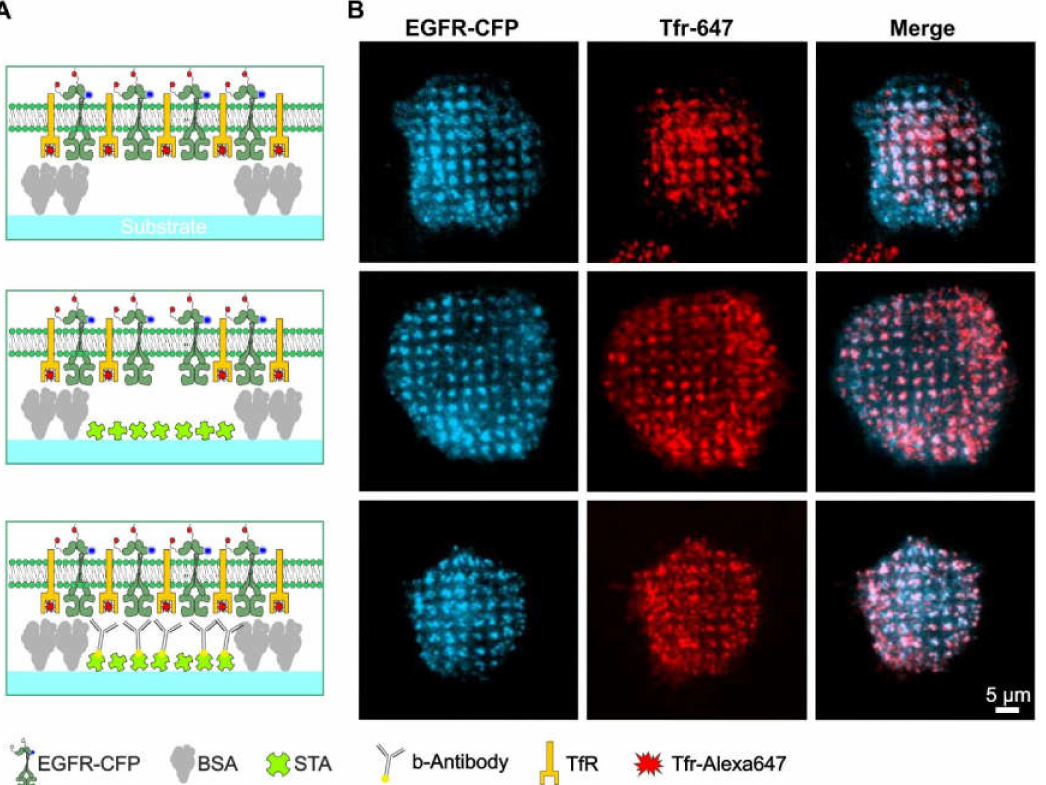
Figure 4. Bait molecules are rearranged irrespective of the presence of specific anti-bait molecules. ( A ) Schematic drawings of the di ff erent degrees of substrate functionalization are presented to the cells. ( B ) TIRF microscopy images of the corresponding HeLa cells are transiently expressing EGFR-CFP as the bait protein. Clathrin structures were visualized using Tfr-Alexa-647 staining (25 µ g / mL for 10 min). Cells were stimulated with 170 nM EGF for 10 min prior to imaging. Abbreviations: b-antibody, biotinylated antibody; BSA, bovine serum albumin; STA, streptavidin; TfR, transferrin receptor; and Tfr, transferrin. Illustrations are drawn not to